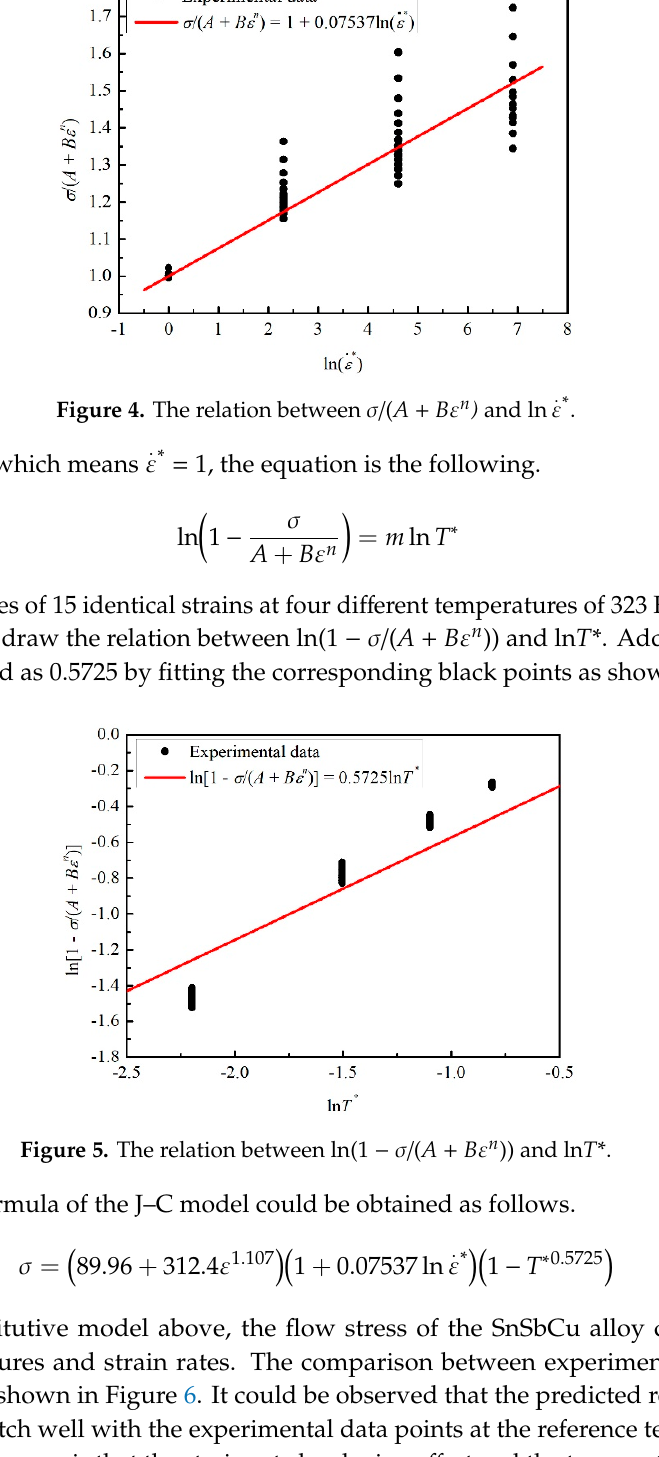
Figure 5. The relation between ln(1 − σ /( A + B ε n )) and ln T *.